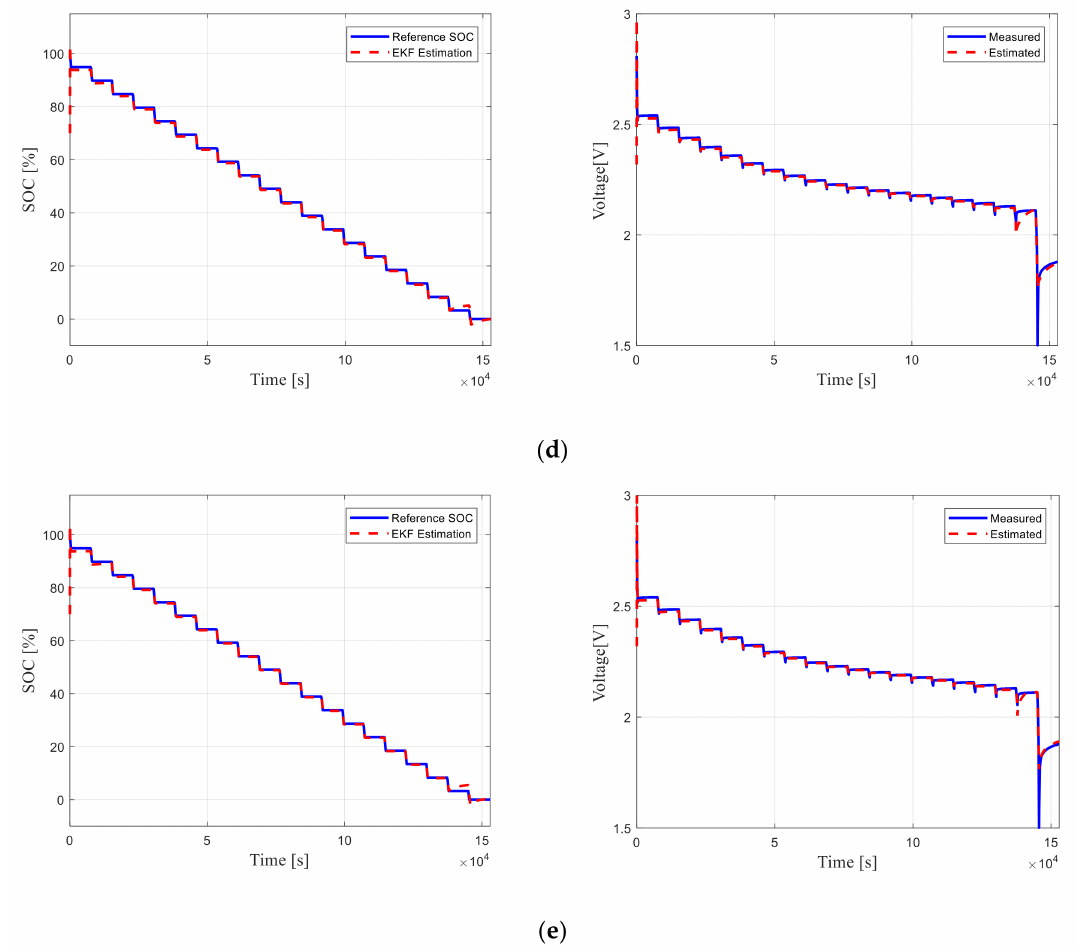
Figure 13. Comparison between the measured and estimation SOC ( left ) and voltage ( right ) profiles obtained during sensitivity analysis performed at 25 ◦ C for: ( a ) R 0 constant; ( b ) R 1 constant; ( c ) C 1 constant; ( d ) R 2 constant; ( e ) C 2 constant.